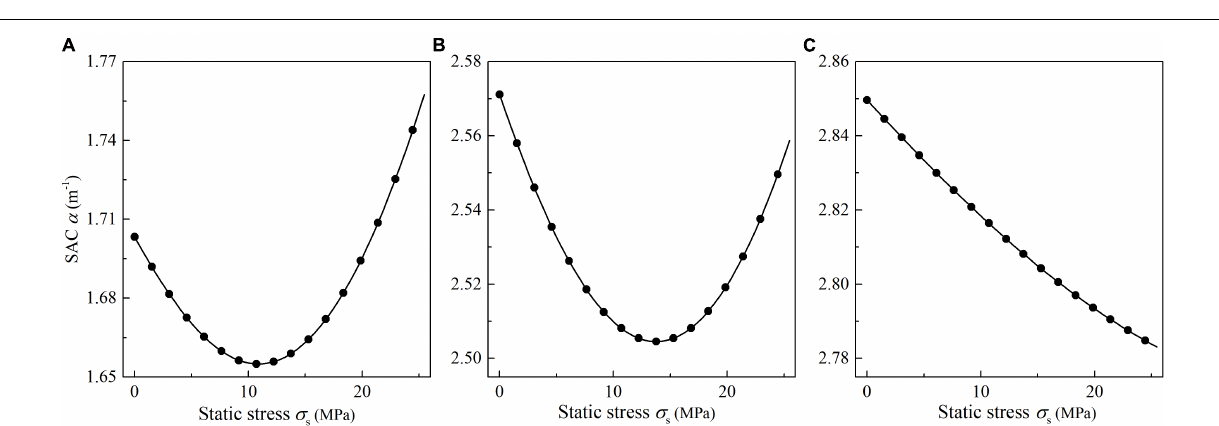
Frontiers in Earth Science |